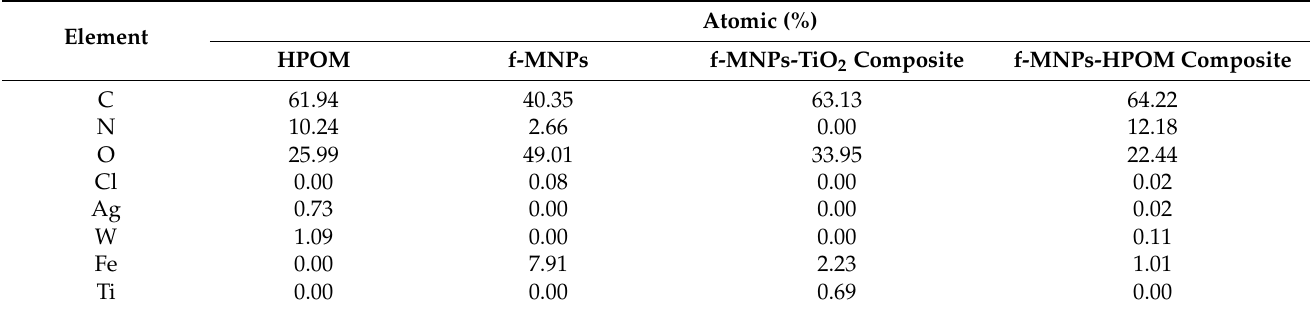
Table 1. The atomic percentage of the elements present in the HPOM, f-MNPs, f-MNPs-TiO 2 compos- ite, and the f-MNPs-HPOM